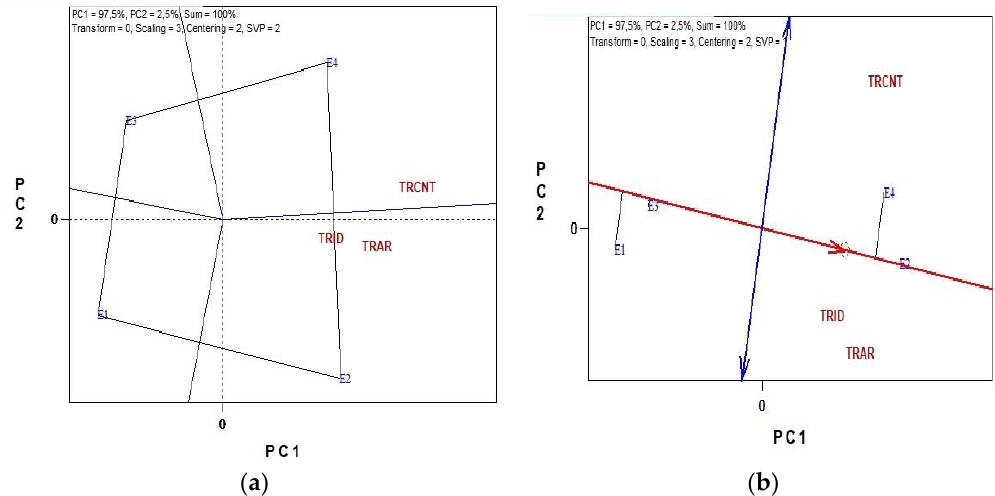
Figure 4. ( a , b ) . Biplot analysis of trash count (TrCnt), trash grade (TrID) and trash area (TrAr), cotton quality measurements across four environments. quality measurements across four